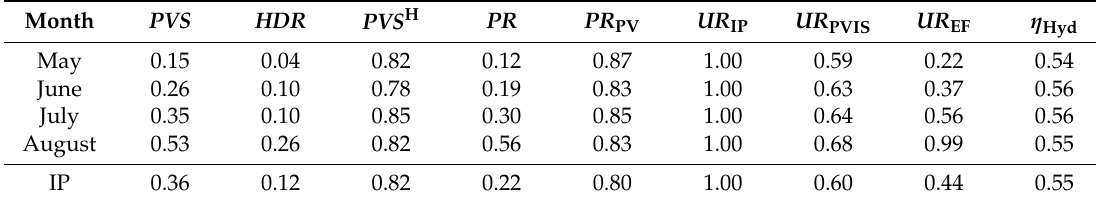
Table 9. Real performance indices in 2018.